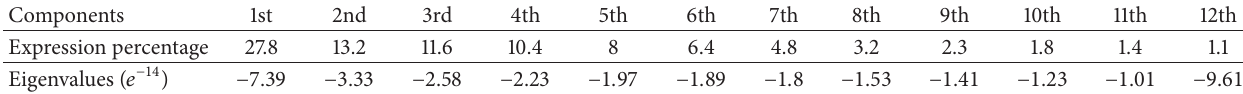
Table 2: Component percentages estimated from principal component analysis.